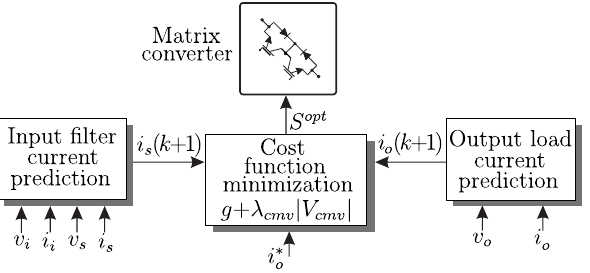
Figure 10. Predictive current control with common-mode voltage block diagram.